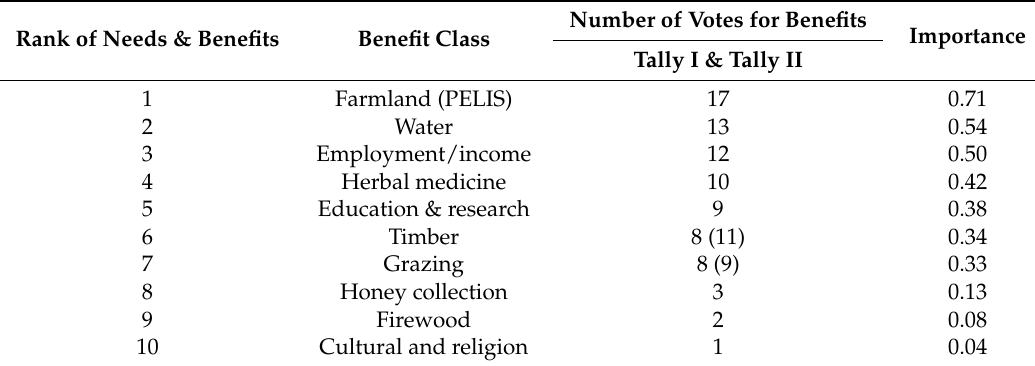
Table 1. The ranking of benefits obtained from Gathiuru Forest (N =